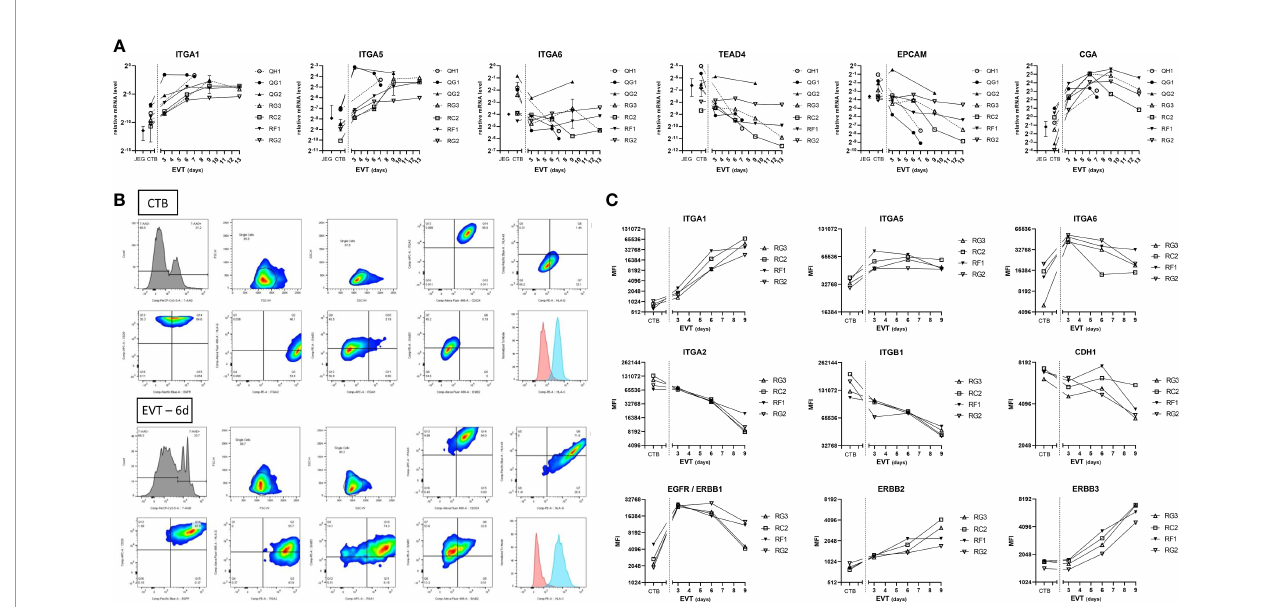
FIGURE 4 | Expression of cell adhesion and epithelial markers in primary trophoblast cultures. (A) Expression of cell adhesion and trophoblast markers at the RNA level by culture days. Cultures (n = 7) were analyzed at the CTB and EVT phase for mRNA expression of ITGA1 , ITGA5 , ITGA6 , TEAD4 , EPCAM , and CGA . (B) Representative gating strategy from one donor (RC2), to select singlet cells by forward-sideward scatter that were viable (7-AAD neg ). The fi gure shows dot blots of the markers studied in CTB (upper two panels) and EVT after 6 days of differentiation (lower two panels). (C) Expression of cell adhesion and epithelial markers at the protein level by culture days. Cultures (n = 4) were analyzed by fl ow cytometry at the CTB and EVT phase for surface expression of integrins, CDH1, and three members of the ErbB family.